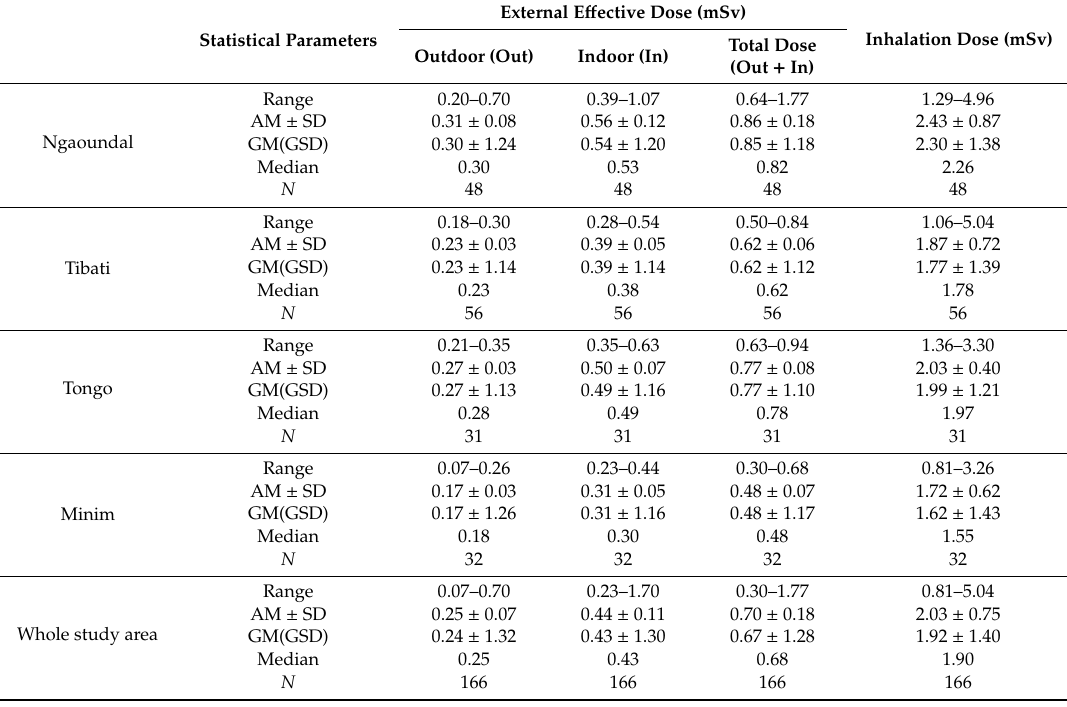
Table 3. External and inhalation dose to members of the public in the bauxite-bearing areas of Southern Adamawa. AM: arithmetic mean, SD: standard deviation, GM: geometric mean, GSD: geometric standard deviation, N: number of